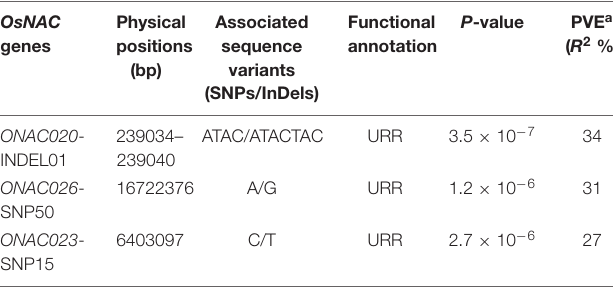
TABLE 1 | NAC gene-derived SNPs associated with grain size/weight traits (length, width, and weight) in rice. OsNAC